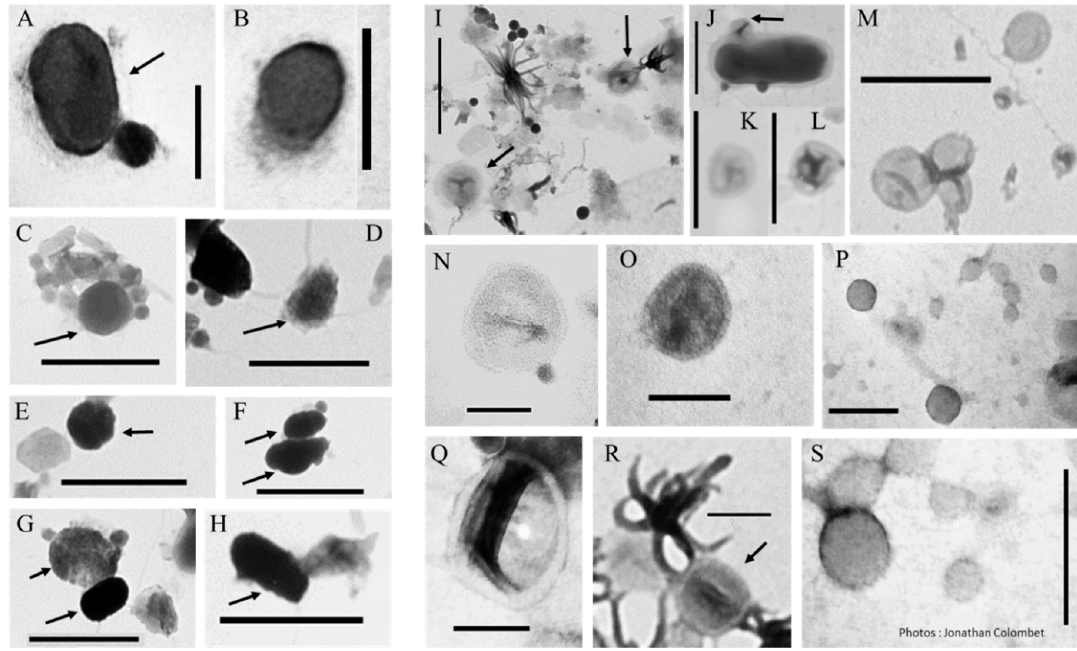
Figure 2. Transmission electron micrographs of biomimetic mineral-organic- (BMOPs) and/or nanobe-like particles ( A – H ) and vesicle-like particles ( I – S ). Arrows indicate the target particles when the samples are heterogeneous. ( A – B , N – S) scale bar: 100 nm, (C – H , I – M) scale bar: 500 nm. Carbon, oxygen, nitrogen, calcium, phosphorus, silicon, iron, sodium, magnesium, manganese,